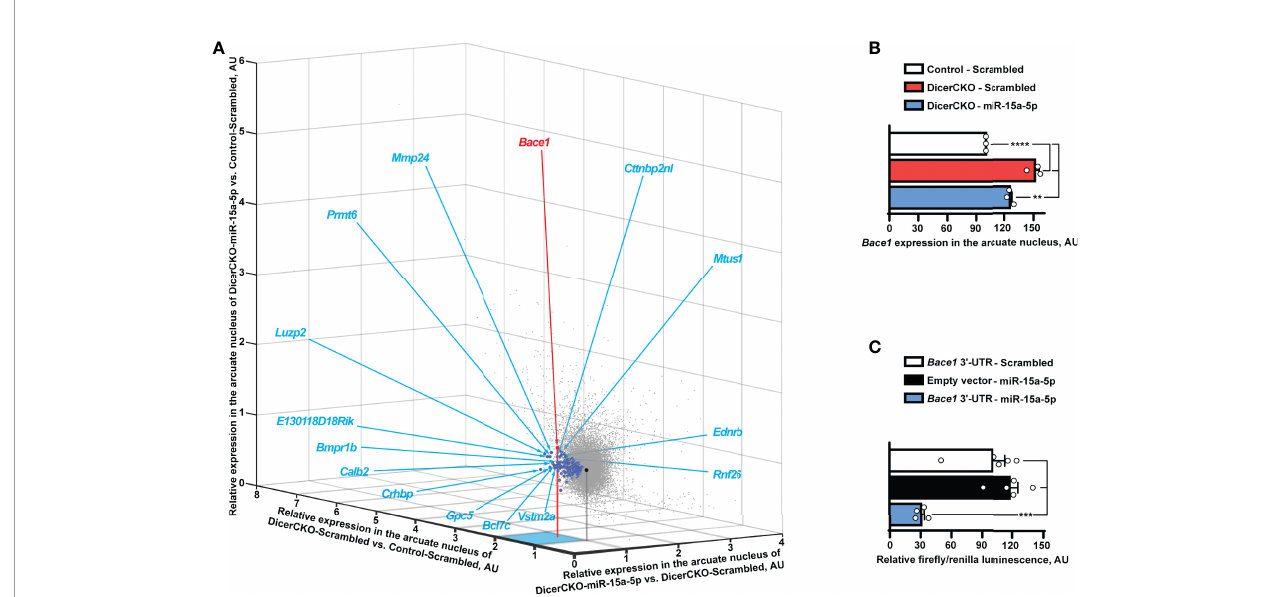
FIGURE 4 | Bace1 is a target of miR-15a-5p. (A, B) Transcriptomics pro fi ling of the arcuate hypothalamic nucleus (see Figure 2 ) reveals genes (indicated by blue circles, Table S4 ) that are both signi fi cantly up-regulated in DicerCKO - Scrambled vs. Control - Scrambled mice and signi fi cantly down-regulated in DicerCKO - miR-15a-5p vs. DicerCKO - Scrambled mice (A) and Bace1 among the latter genes (panel B and indicated with a red circle in A ) that demonstrated the highest signi fi cance of up-regulation in DicerCKO - Scrambled group (n = 3). Black circle indicates the central point of the graph where relative expression vs. any group is equal. Acronyms of 15 genes with the highest fold change of up-regulation in DicerCKO - Scrambled vs. Control - Scrambled group are depicted (see Table S4 for more details). (C) Validation of Bace1 as a target of the mmu-miR-15a-5p by dual-luciferase assay (n = 5, 5, 4, respectively for Scrambled treated, empty vector and miR-15a-5p-treated groups). Error bars represent SEM. ** p < 0.01; *** p < 0.001; **** p < 0.0001 as assessed by 1-way (F (2, 6) = 87.81 and F (2, 11) = 21.1 for (B, C) , respectively) ANOVA followed by Holm-S ̌ ı ́ da ́ k pairwise comparison Scrambled mice ( Table S4 , blue circles in Figure 4B ). The